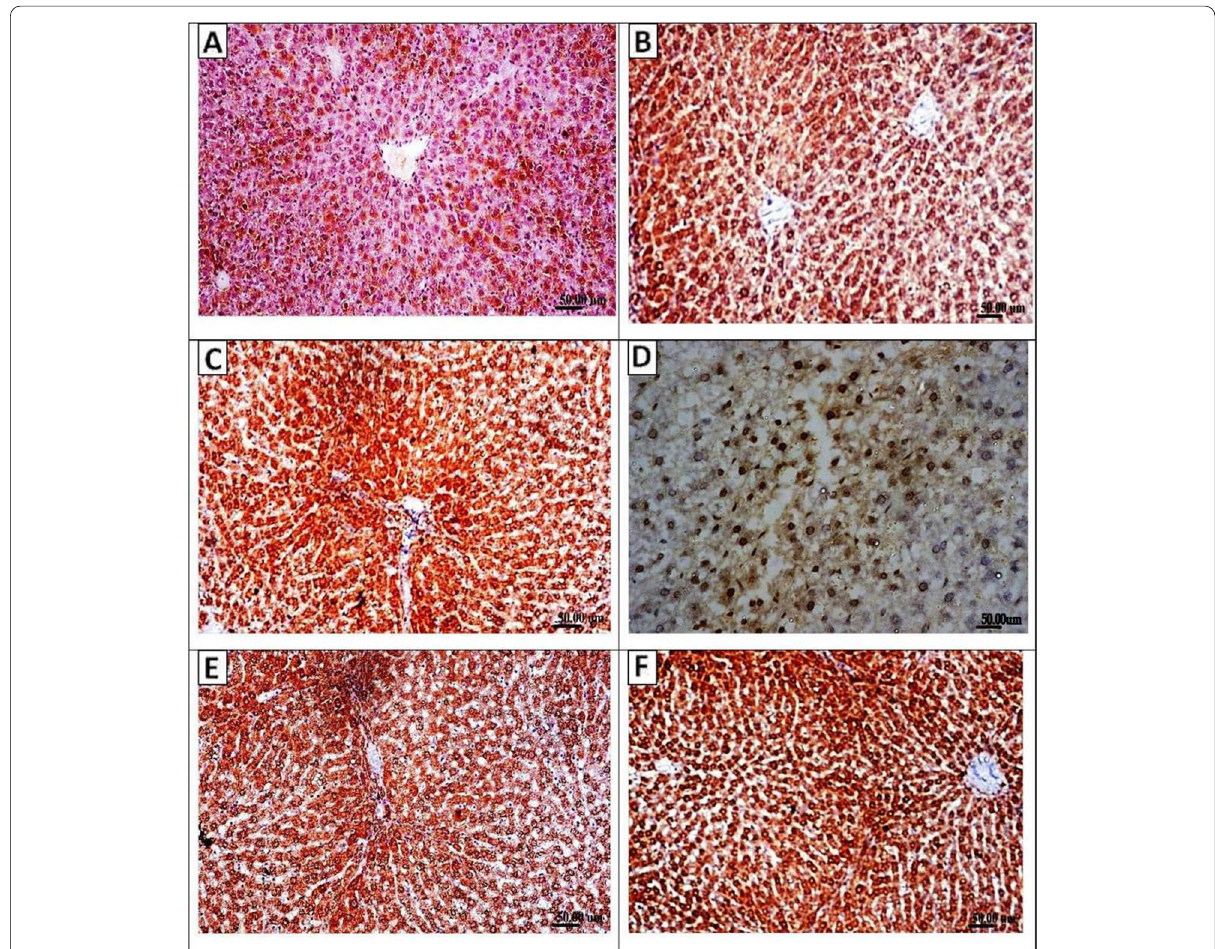
Fig. 6 Representative images for immunohistochemical staining of Nrf2 expression in liver tissue sections of the different studied groups. Lower levels of Nrf2 protein expression were detected in the vehicle group ( A ). Mild to moderate Nrf2 expression scores in the probiotic control group ( B ) and positive APAP control group ( C – D ). Moderate to strong Nrf2 expressions were detected in rats that received probiotic LGG as a prophylactic ( E ) or as a treatment ( F ).